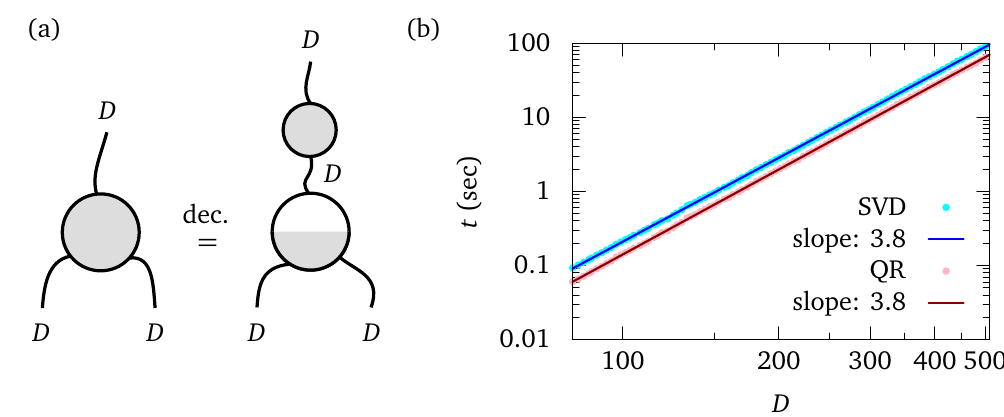
Figure 48: (a) Tensor decomposition arising when transforming a bTTN into cen- tral gauge. (b) Corresponding computational performances for QR decomposition (LAPACK routine zgeqrf ) and SVD (LAPACK routine zgesdd ). The graph shows the computation time, averaged over 50 runs, needed for the decomposition shown in (a) (performed on a tensor with random entries without any symmetries) as a function of the bond dimension D .